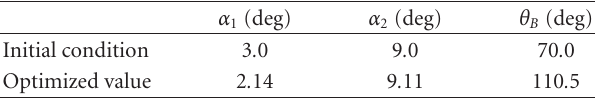
Figure 13: Optimization design history for (a) the magnetic field angle and (b) geometry angles.